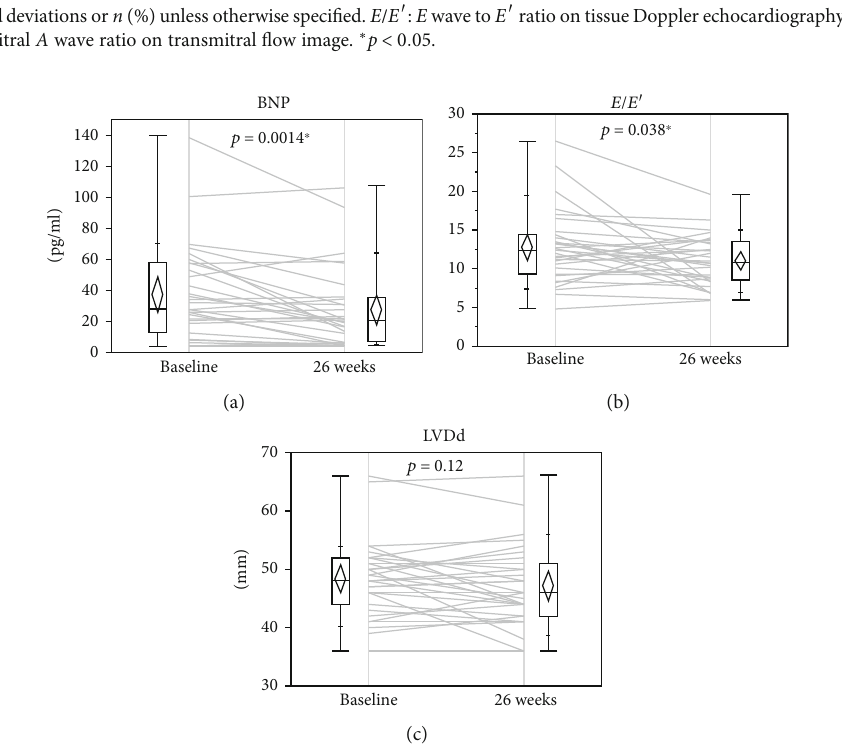
Figure 1: Comparison of clinical parameters at baseline and 26 weeks after liraglutide introduction ( N = 31 ). Changes in (a) BNP, (b) E / E ′ , and (c) LVDd in study subjects. BNP: B-type natriuretic peptide; E / E ′ : E wave to E ′ ratio on tissue Doppler echocardiography; LVDd: left ventricular diastolic